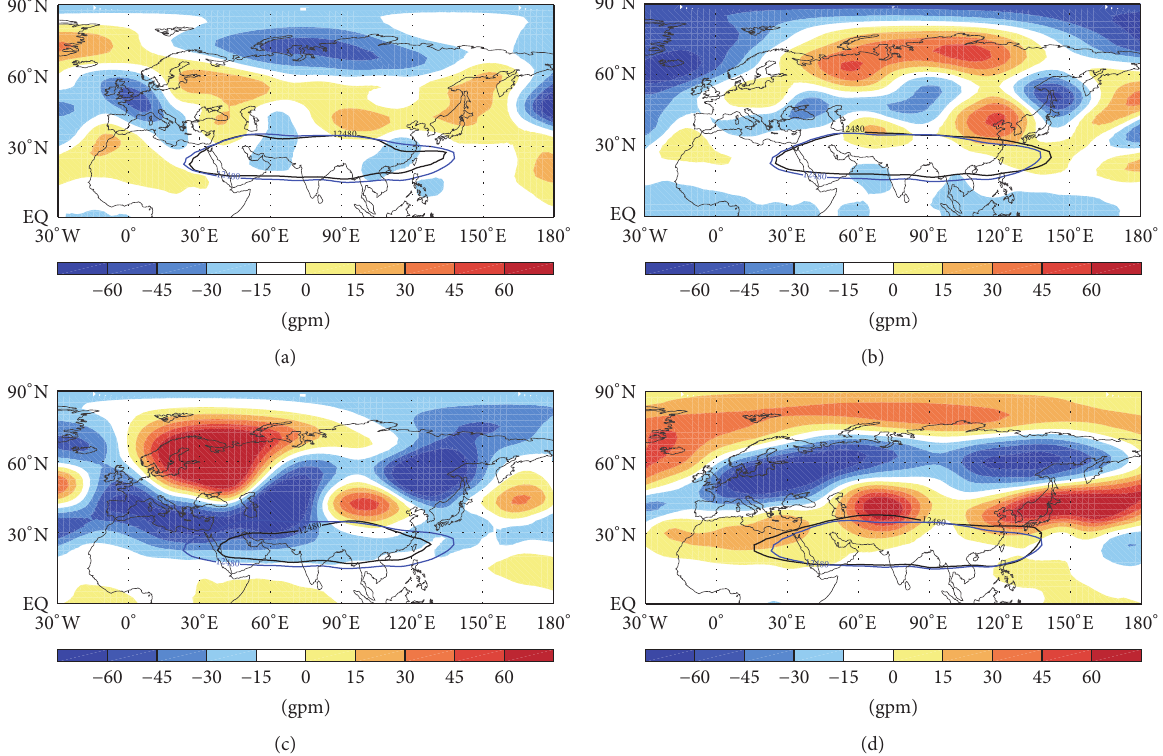
Figure 9: 200 hPa GPH anomalies (shading) (units: gpm) of the WBWD pattern in the summers of (a) 1966, (b) 1967, (c) 1972, and (d) 1978; blue lines denote the climatology of 12480 gpm and black lines indicate 12480 gpm for the typical